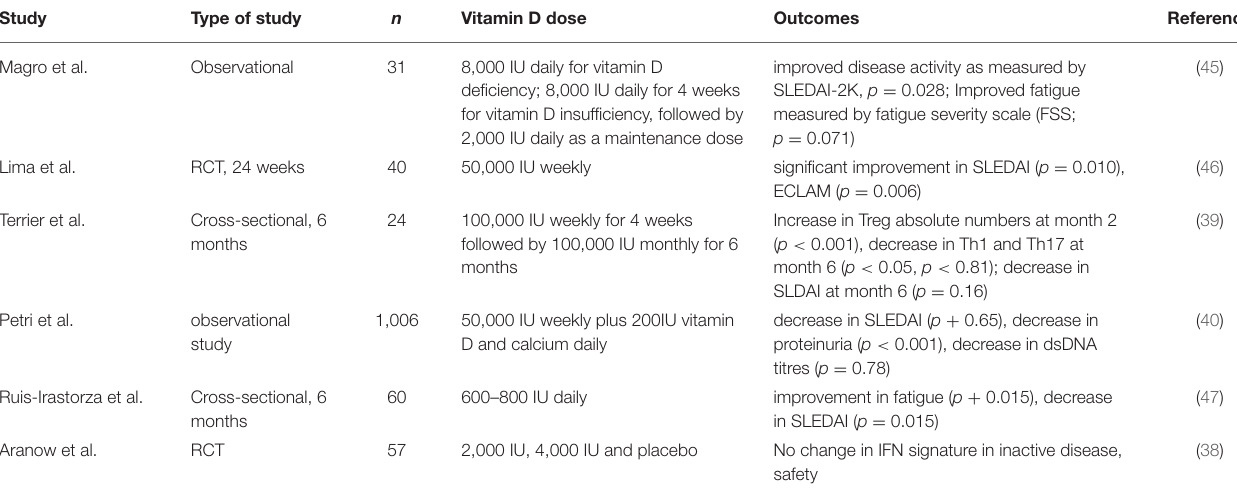
TABLE 1 | Studies looking at vitamin D treatment and disease activity. Study Type of study n Vitamin D dose Outcomes Reference Magro et